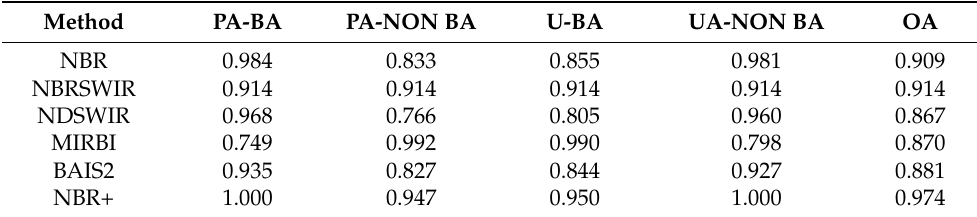
Table 4. Results of bi-temporal thematic accuracy assessment on test sites including water bodies and clouds (Group A).